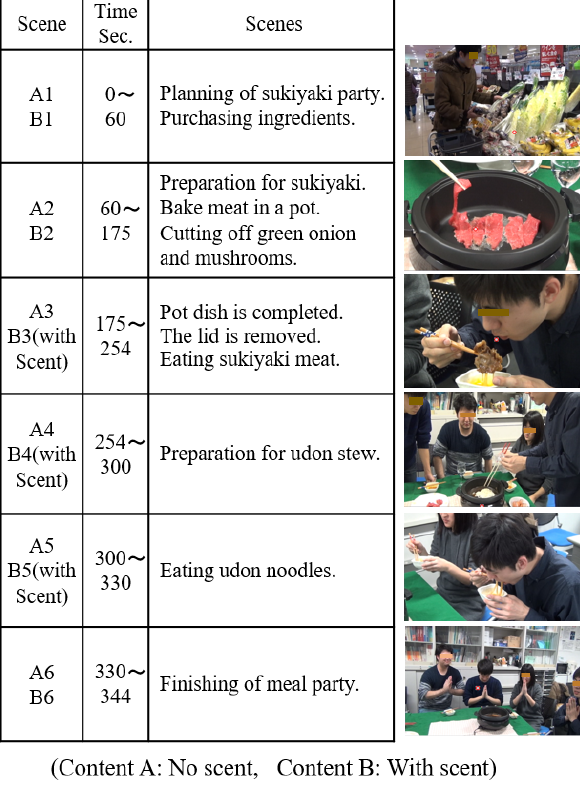
Figure 3. Story lines of sukiyaki gourmet videos.